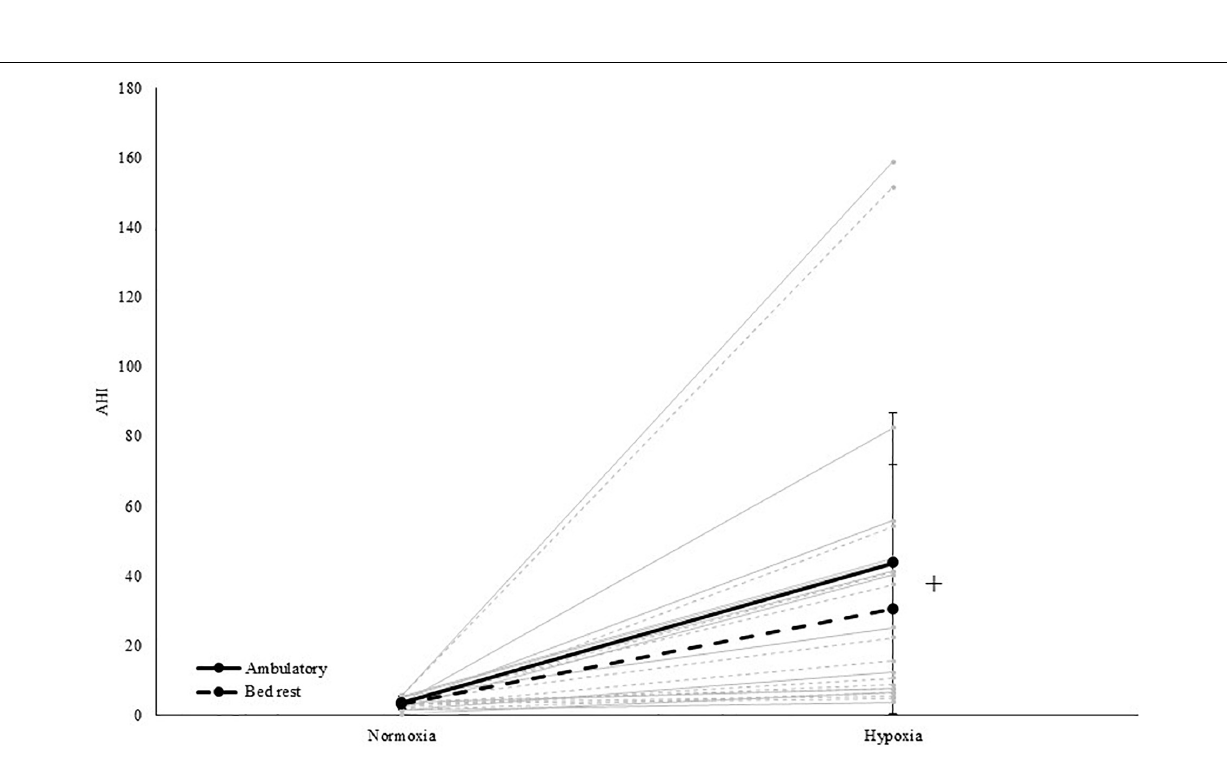
Frontiers in Neuroscience |